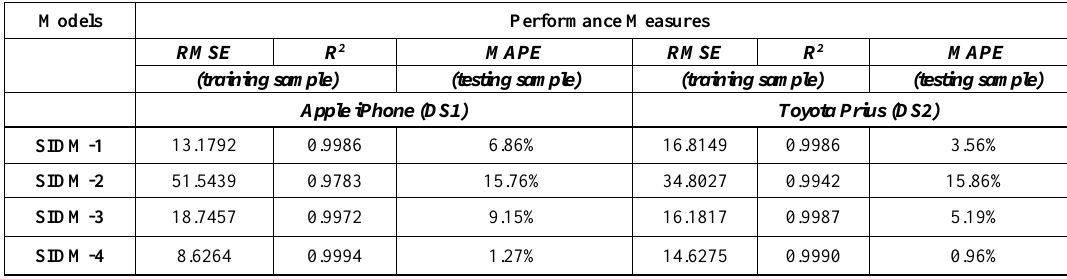
Table 3. Statistical measure